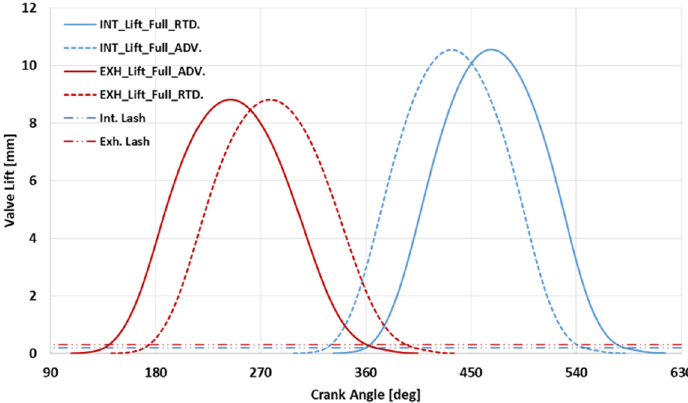
Figure 5. Engine intake and exhaust valve lift curves.